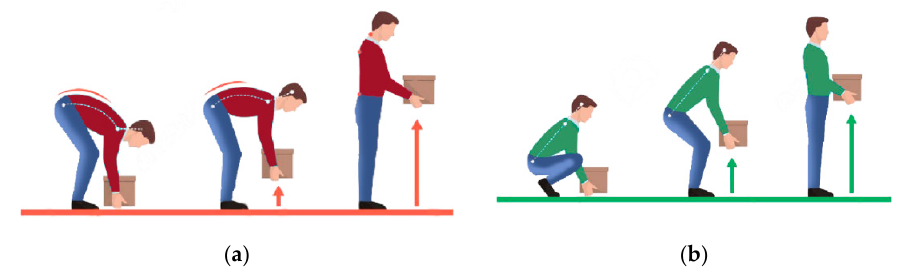
Figure 6. Expert prescribed posture: ( a ) wrong posture and ( b ) correct posture. Table 4. Subject participation in experiments.